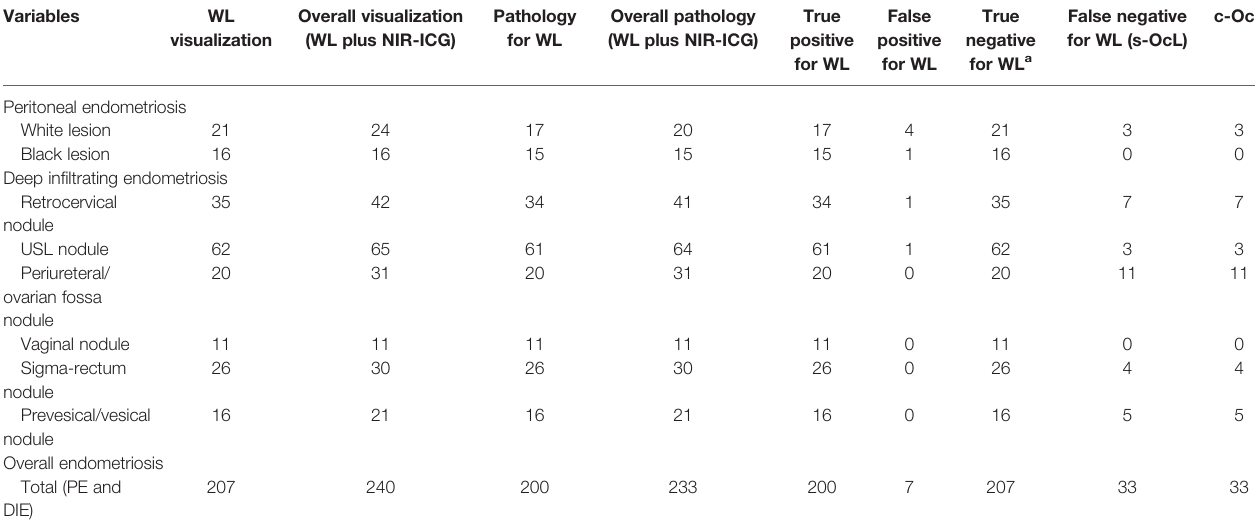
TABLE 3 | Intraoperative and pathologic data collection resulting from WL vision and the combination of the two techniques (WL plus NIR-ICG). Variables